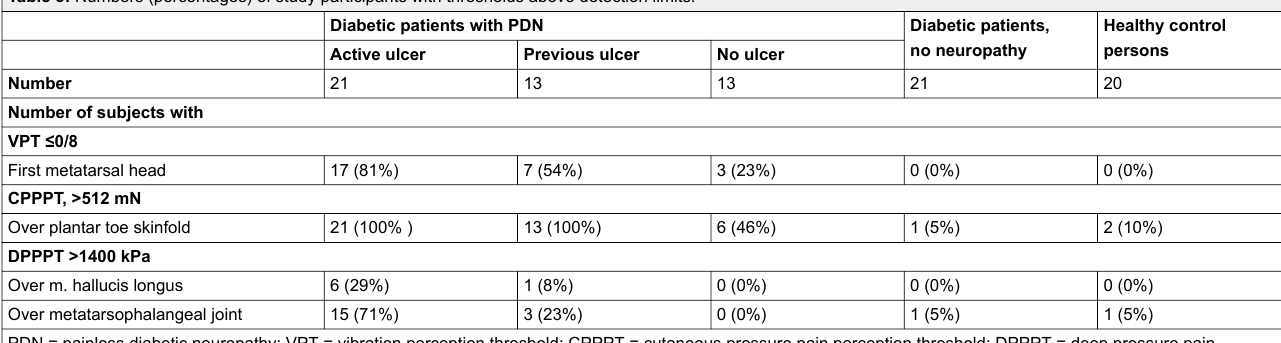
Table 3: Numbers (percentages) of study participants with thresholds above detection limits.